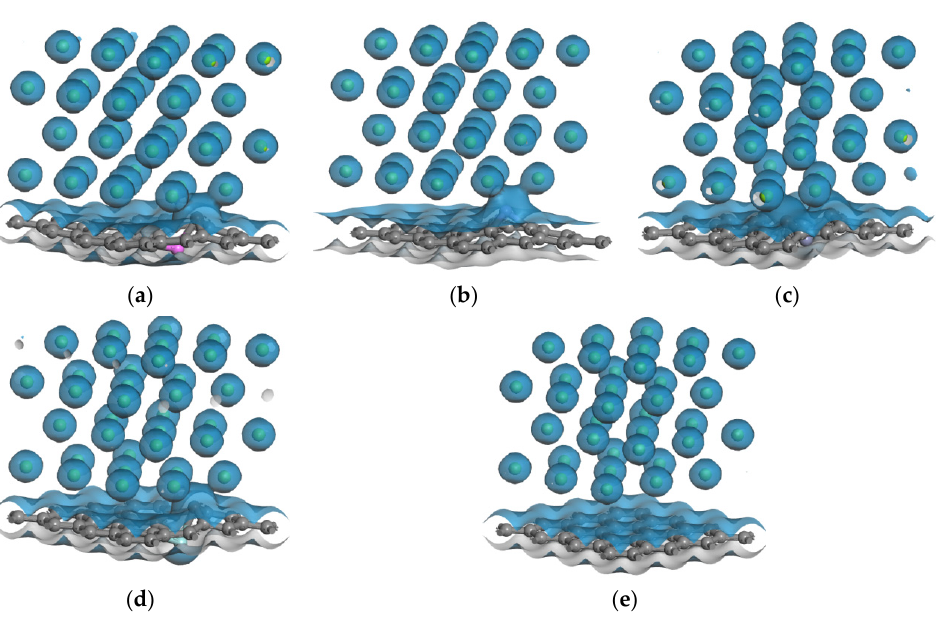
Figure 8. Isosurfaces of the electron densities of five interface models: ( a ) Al-doped interface, ( b )